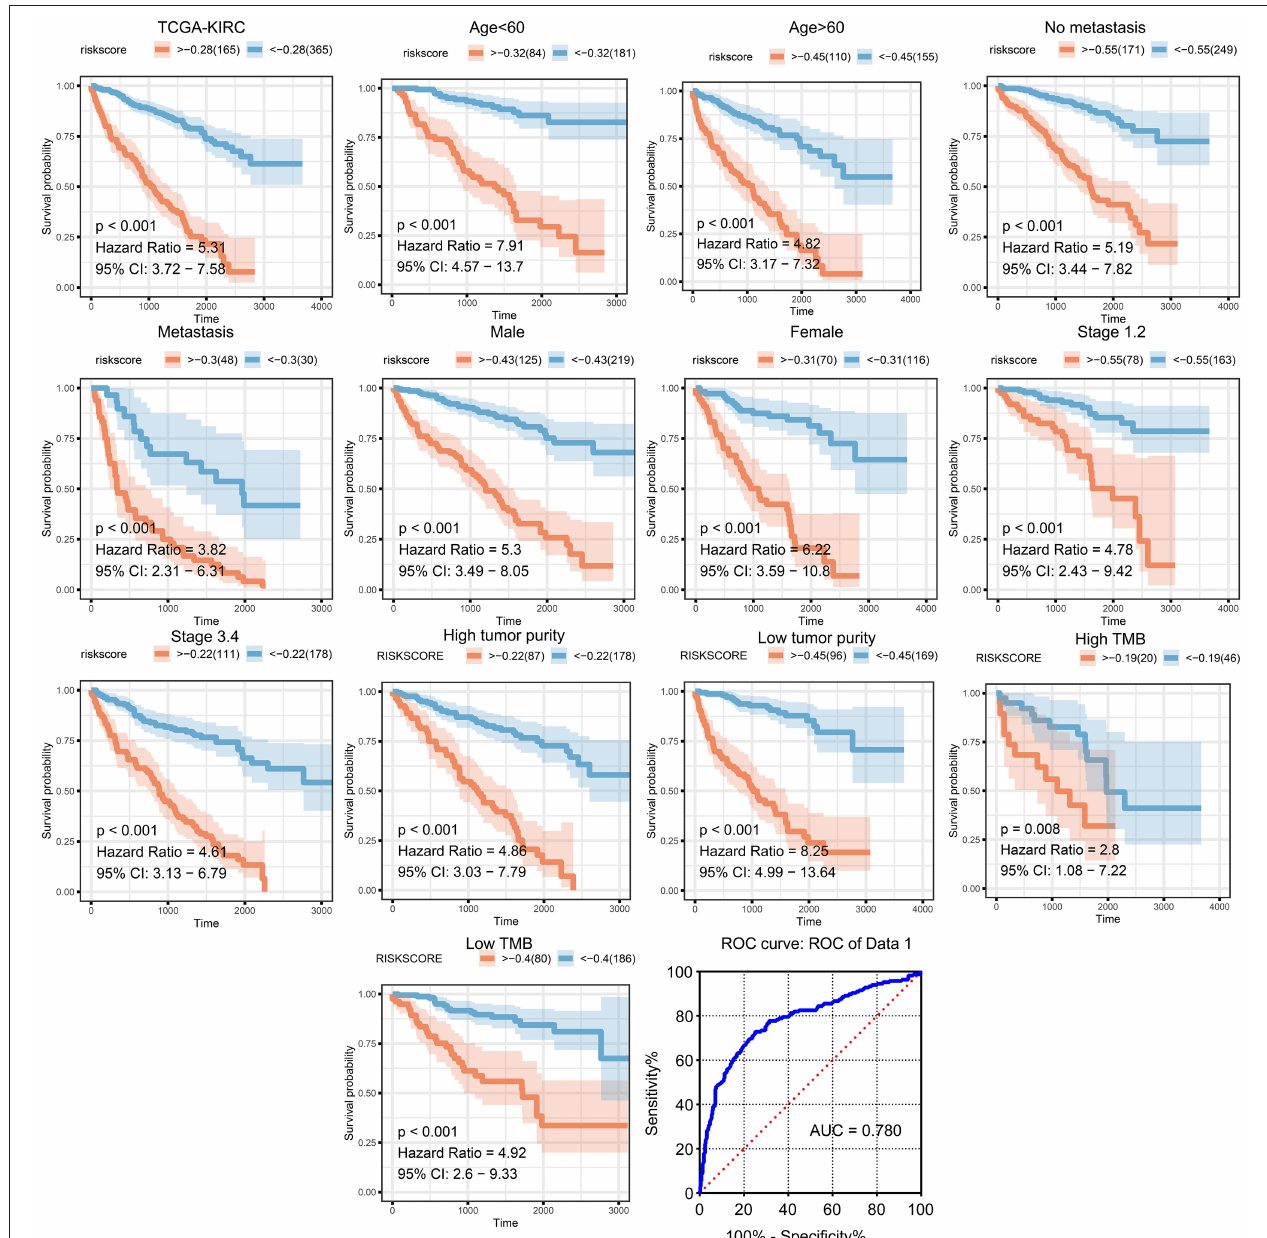
FIGURE 5 | Validation of the prognostic model in clinical subgroups. The patients in high-risk groups for renal clear cell cancer (TCGA: P < 0.001; HR = 5.31) showed survival risk against low expression groups, with the area under curve (AUC) = 0.780. The risk score was evaluated in clinical subgroups, including age, gender, stage, metastasis, tumor purity, and tumor mutation burden. P-values of all subgroups validations were < 0.05, indicating that this model has good predictive ability.